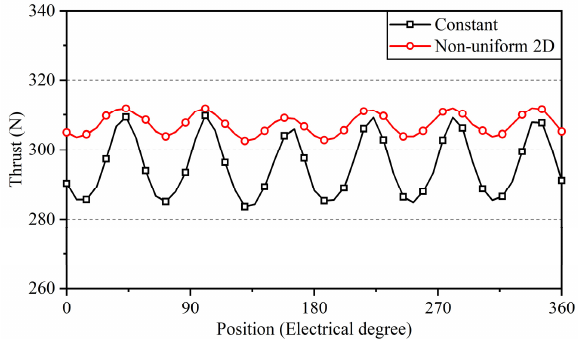
Figure 14. The thrust comparison of DCB ‐ VRLM with constant and non ‐ uniform air gap.